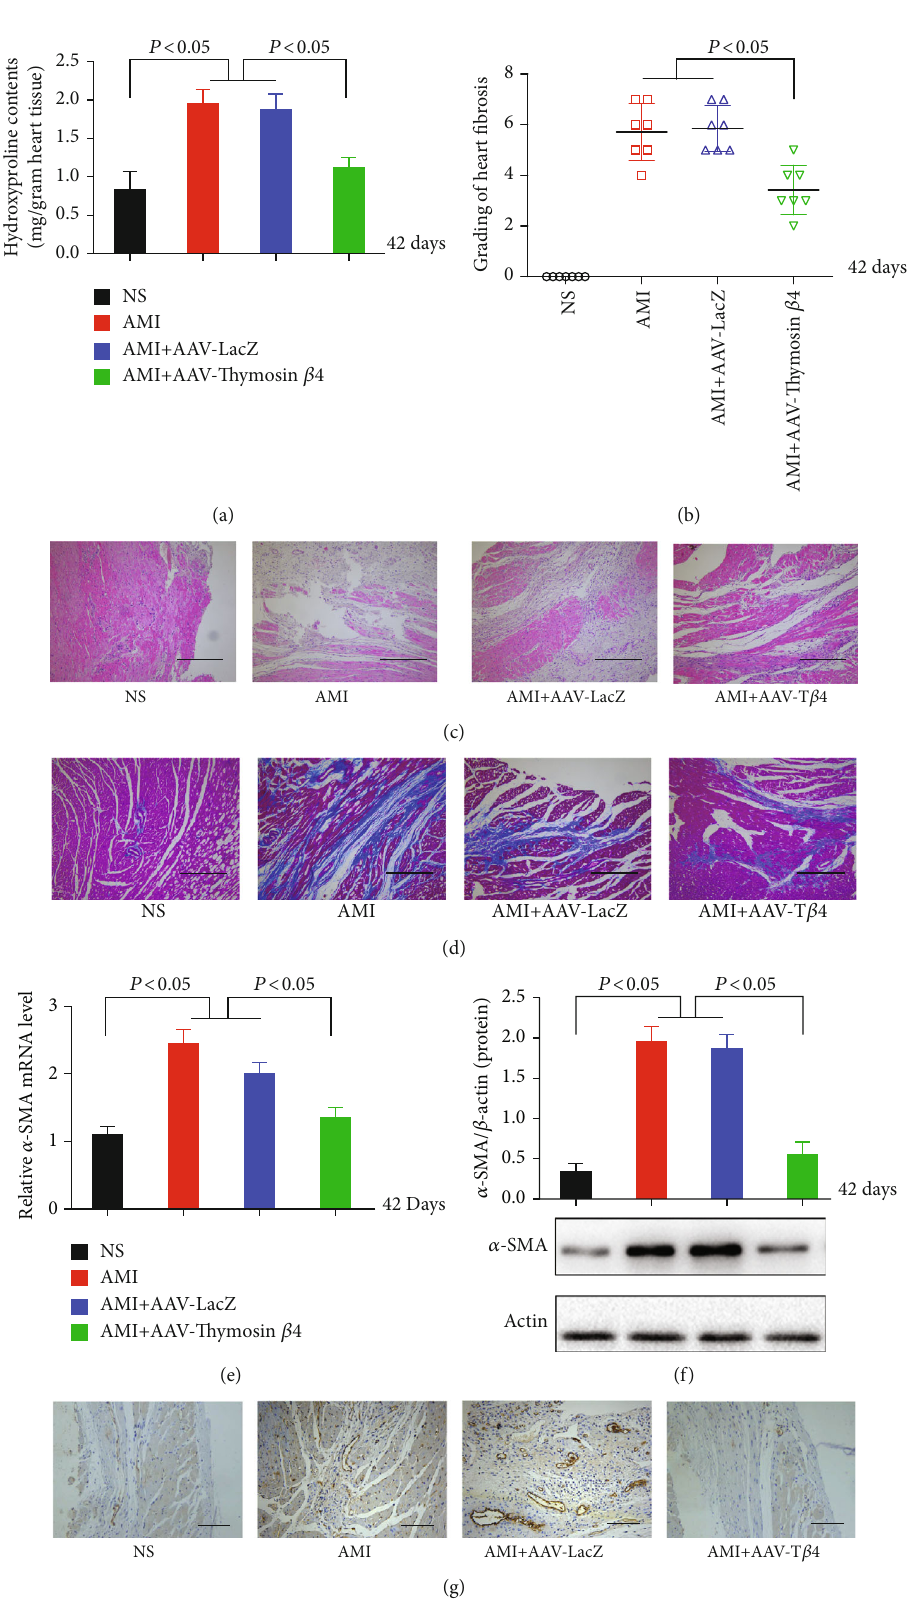
Figure 5: AAV-T β 4 alleviates ligation-induced heart fi brosis in mice. Detection of cardiac hydroxyproline content (a), fi brosis score (b), HE staining (c), and Masson staining (d) in the NS, AMI, AMI +AAV-LacZ, and AMI +AAV-T β 4 groups. Expression of α -SMA in the mouse heart tissues detected by rt-PCR (e), Western blot (f), and immunohistochemistry (g). Scare bars = 100 μ